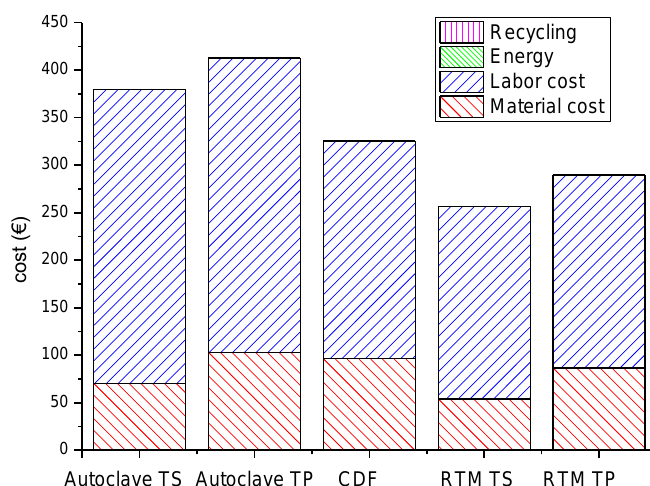
Figure 7. Total cost for the different manufacturing scenarios examined.